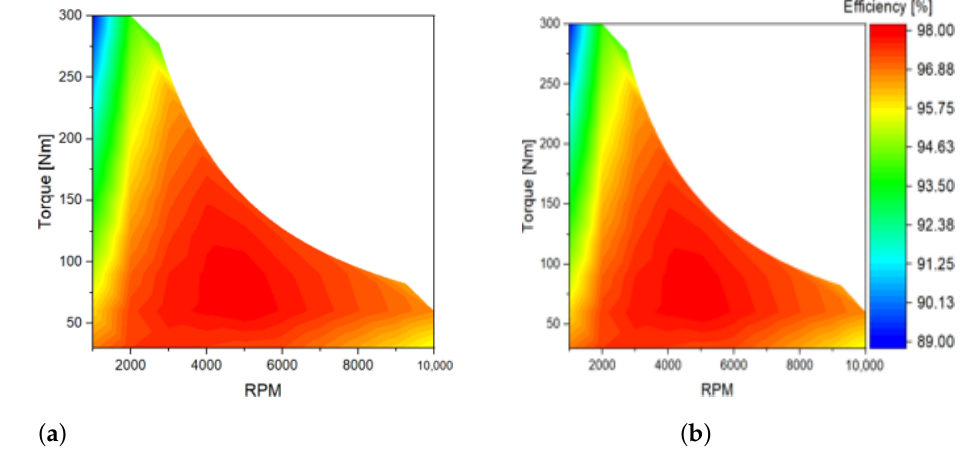
Figure 15. Efficiency maps: ( a ) conventional method. ( b ) proposed